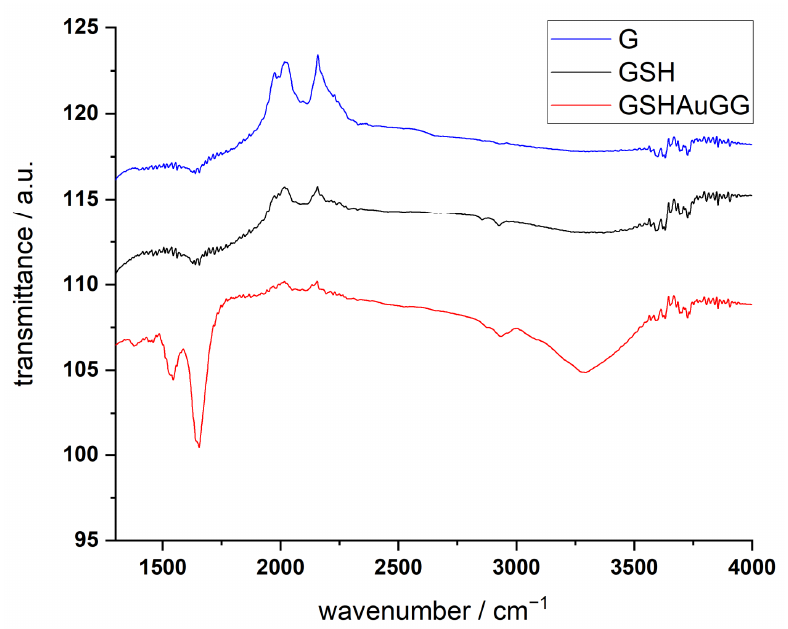
Figure 4. Infrared spectroscopy spectra of glass (G), glass modified with –SH groups (GSH), and the final coating on glass (GSHAuGG).